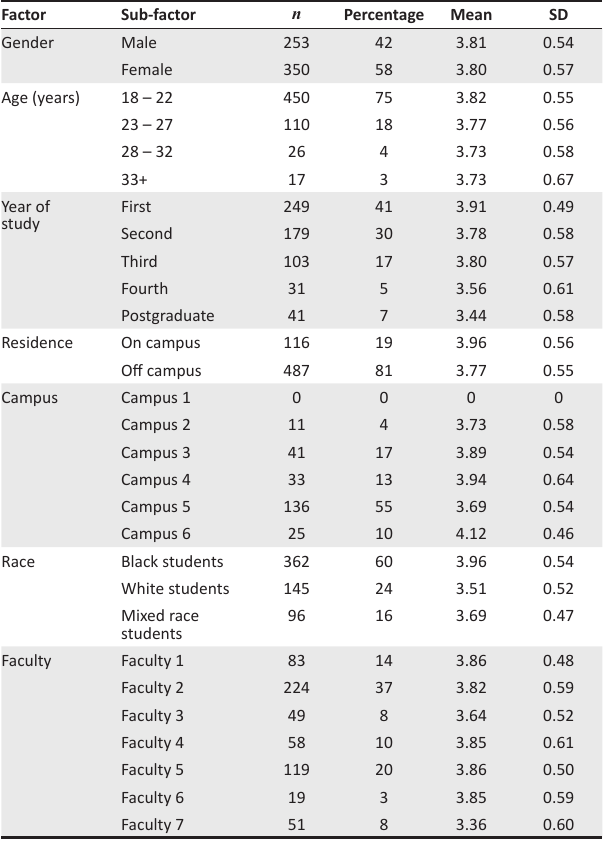
TABLE 2: The demographic profile of the quantitative